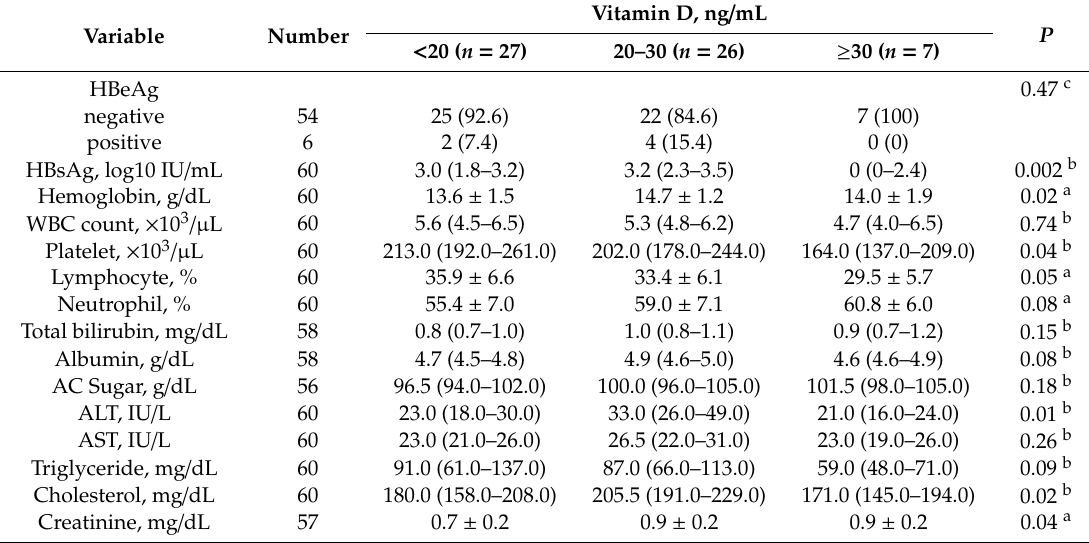
Table 2. Laboratory data of patients included in the study.